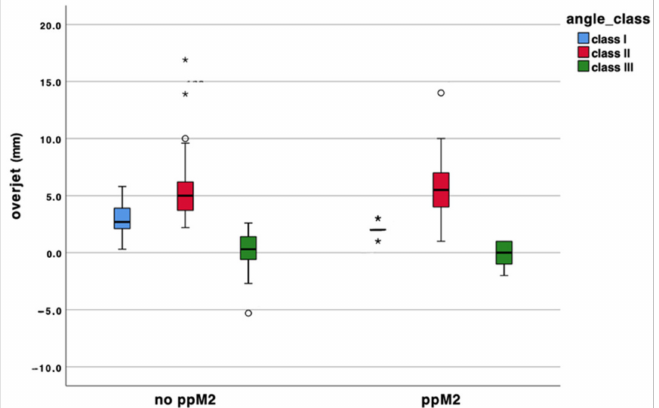
Figure 6. Relationship between overjet and angle-classification in the experimental and control group.